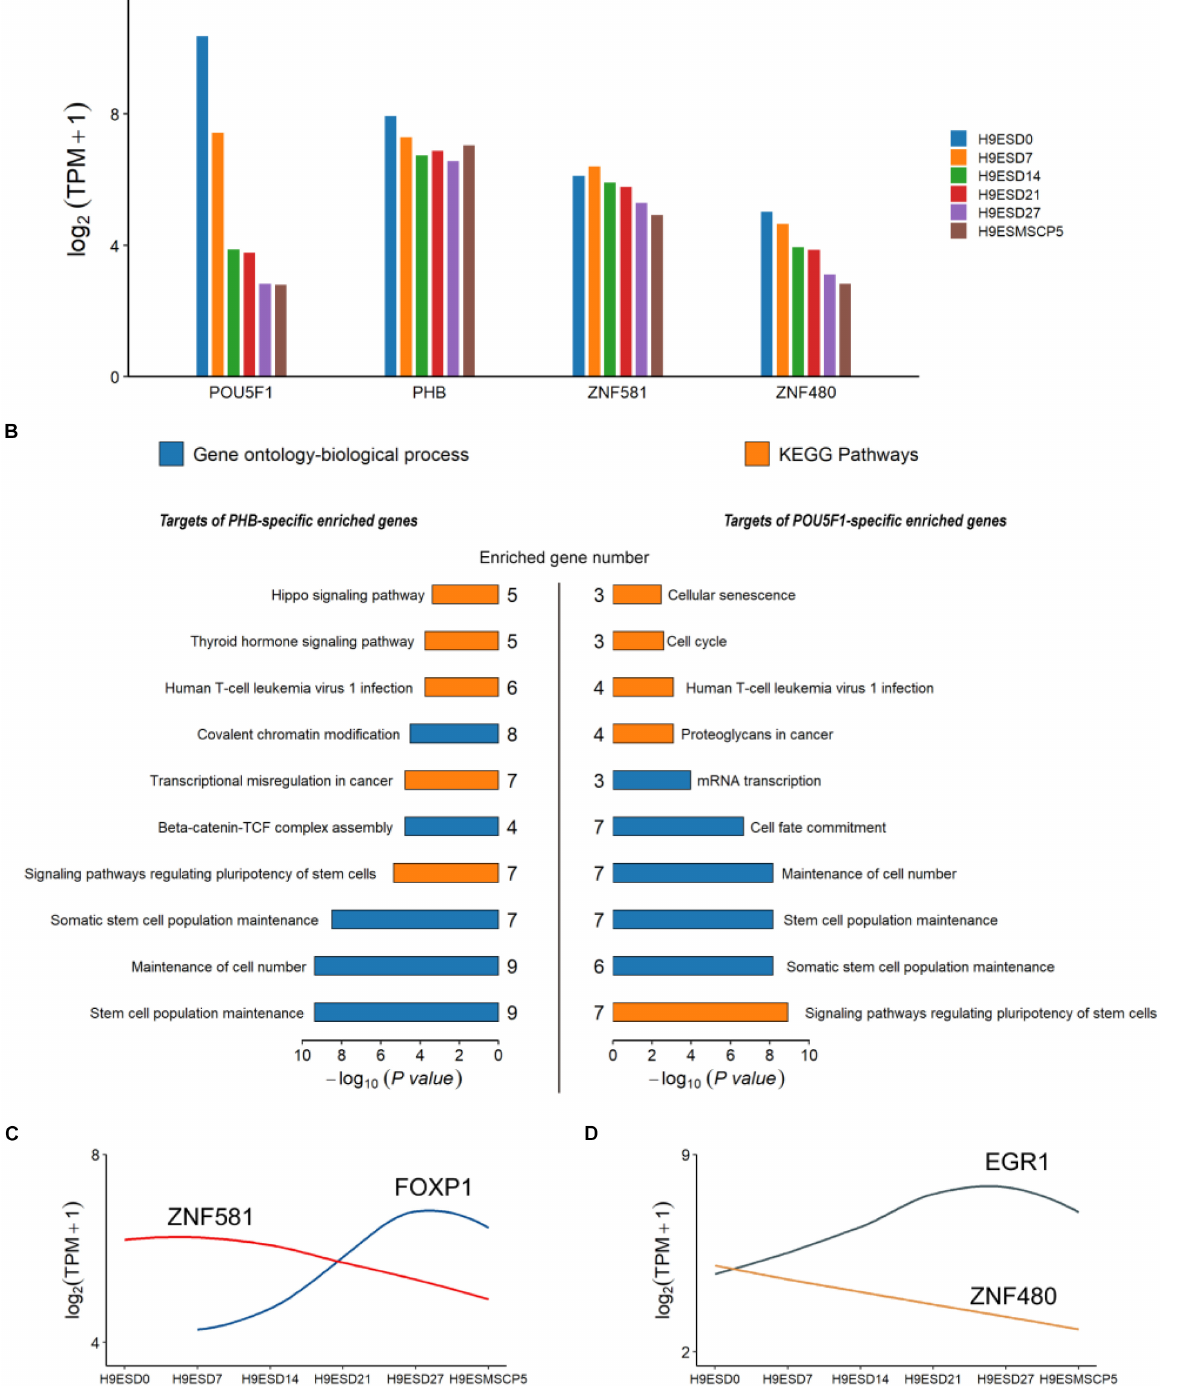
Frontiers in Cell and Developmental Biology |